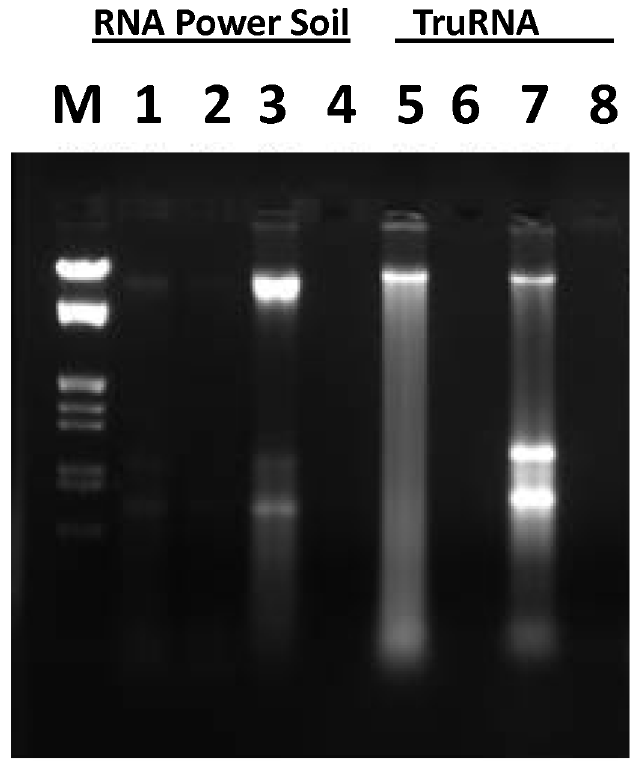
Figure 1. Reagent test and process development sample evaluation. Ethidium bromide stained 1.2% agarose TAE electrophoresis image (3 V/cm 6 90 min) comparing reagent systems used for stream sediment RNA or TNA recovery. Lane M; Marker III (Roche), lanes (1, 5) extraction product from NOAA sediment core, lanes (2, 6) extraction product from New Horizon sediment core, lanes (3, 7) extraction products from the A- horizon surface soil sample, lanes (4, 8) extraction products from the iron cemented clay